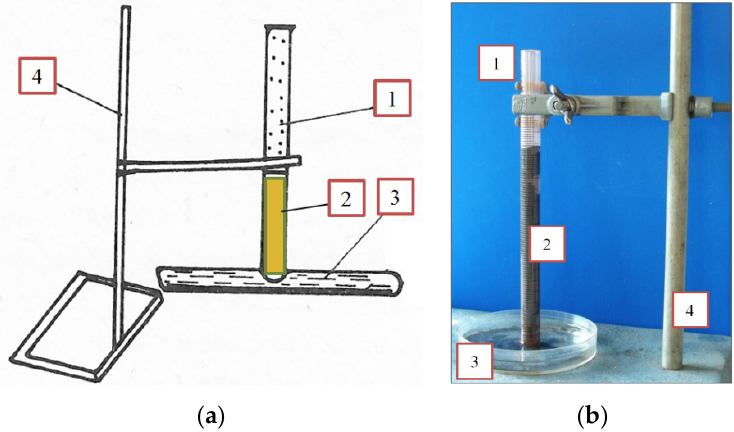
Figure 3. Apparatus for absorptivity measurement: ( a ) Scheme; ( b ) Photo. 1—Capillary, 2—Analysed material, 3—Bowl containing a liquid, 4—Holder.